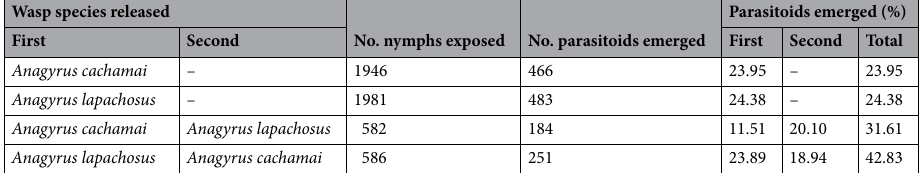
Table 1. Parasitism of Hypogeococcus sp. nymphs by two parasitoids, Anagyrus cachamai and A. lapachosus , when released alone or